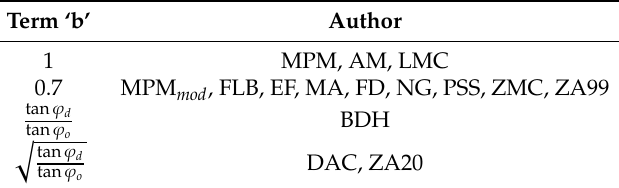
Table 3. Terms ‘b’ of Equations (3a) and